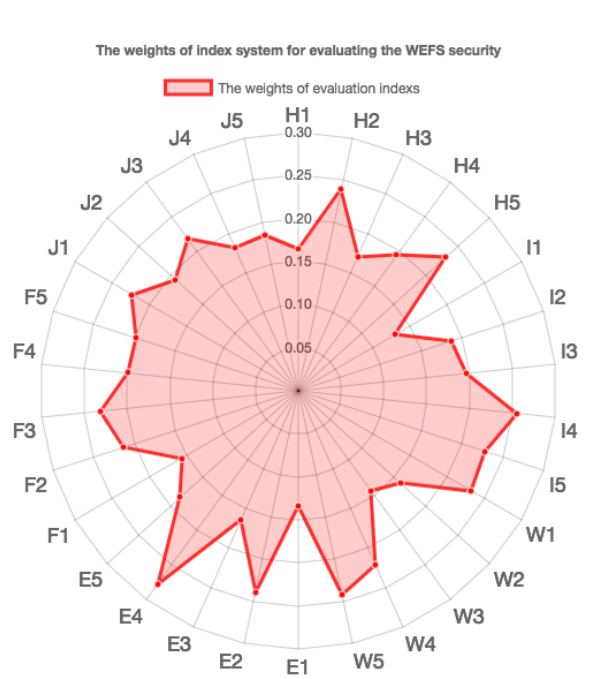
Figure 7. The weights of index system for evaluating the water-energy-food symbiotic security.